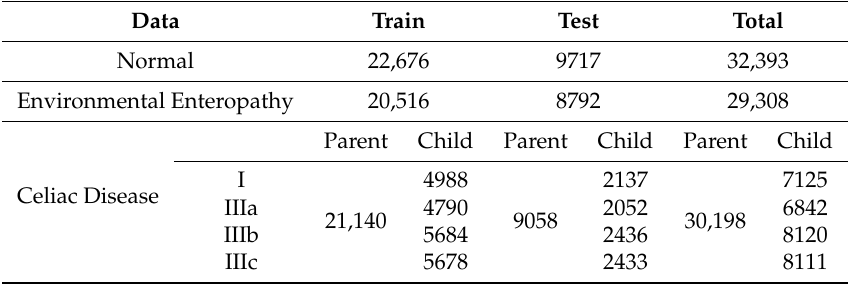
Table 2. Dataset used for Hierarchical Medical Image Classification